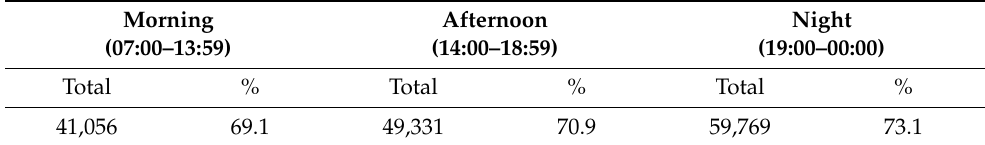
Table 4. Reference scenario: Demand covered by time